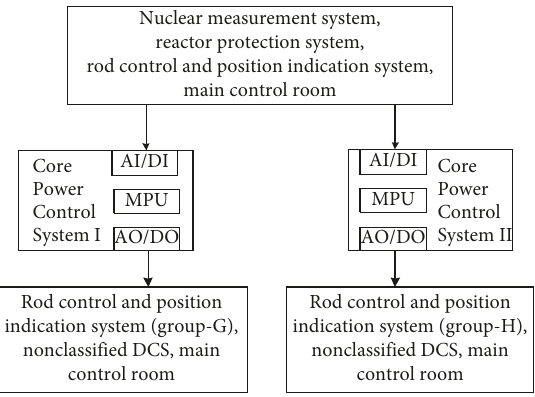
Figure 4: Composition of the reactor power control